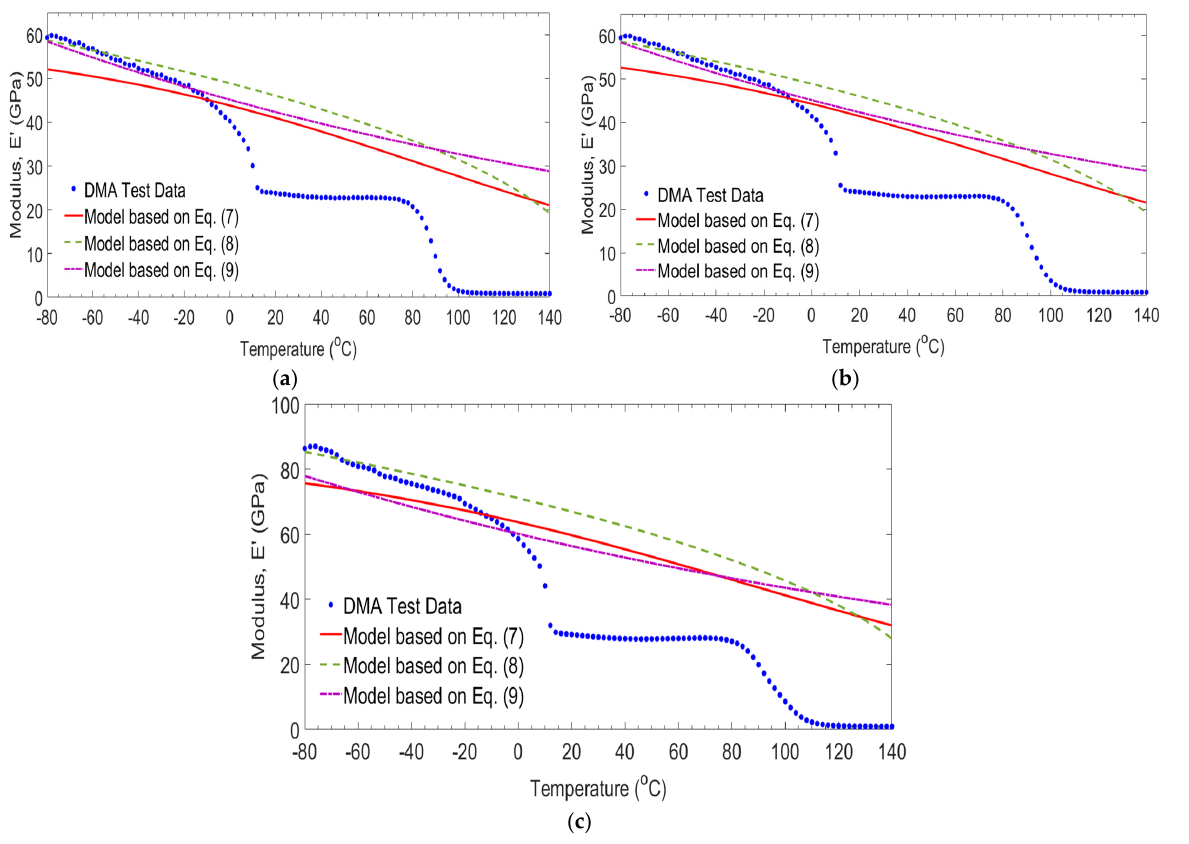
Figure 12. Comparison of measured and empirical models for − 80/G laminates at frequencies of 1 Hz ( a ), 10 Hz ( b ) and 100 Hz ( c ).